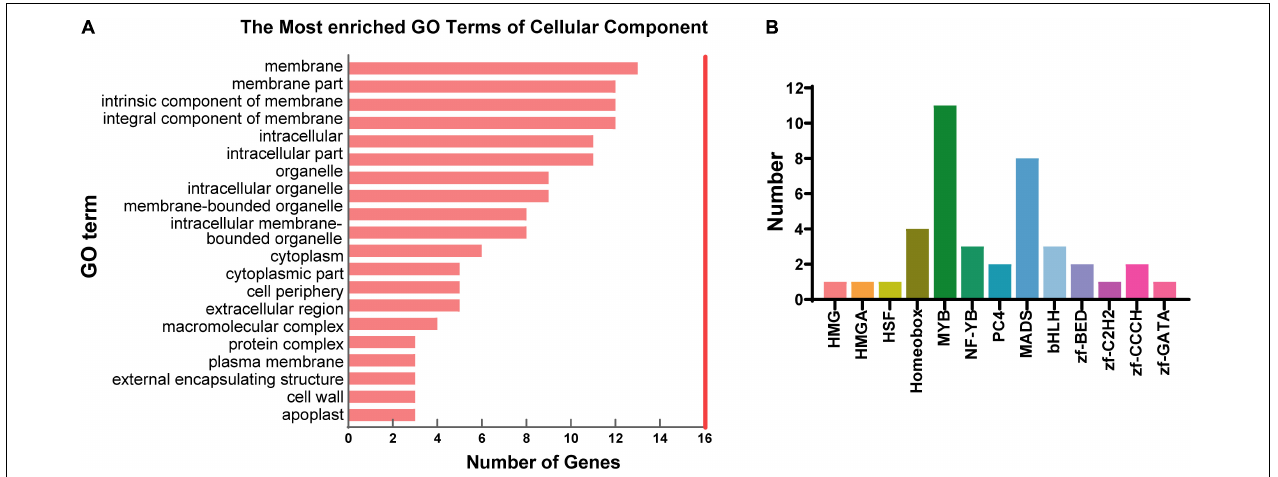
FIGURE 4 | Analysis of differentially expressed genes and transcription factors (TFs) targeted by lncRNAs. (A) GO analysis of differentially expressed genes targeted by DElncRNAs. Top 20 terms of cellular component were displayed. (B) Number of TFs belonging to different families targeted by lncRNAs.